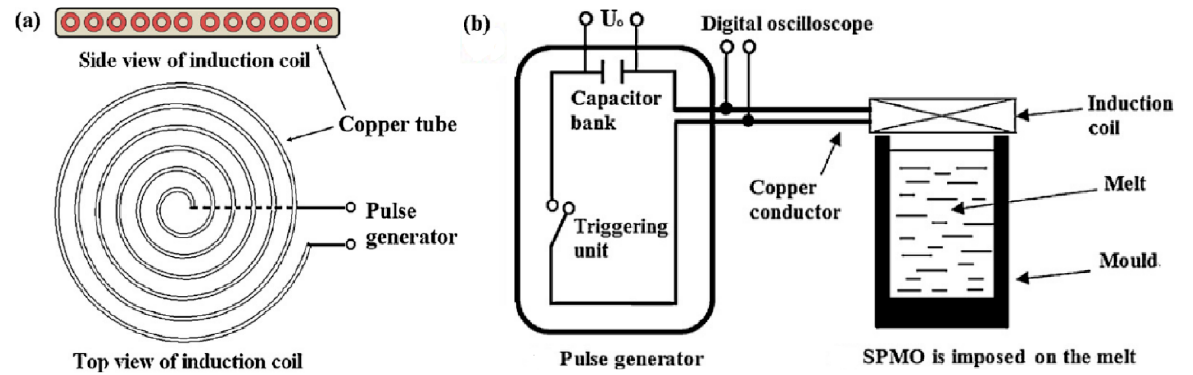
Figure 10. ( a ) Coil appearance, and ( b ) the scheme of the experimental setup